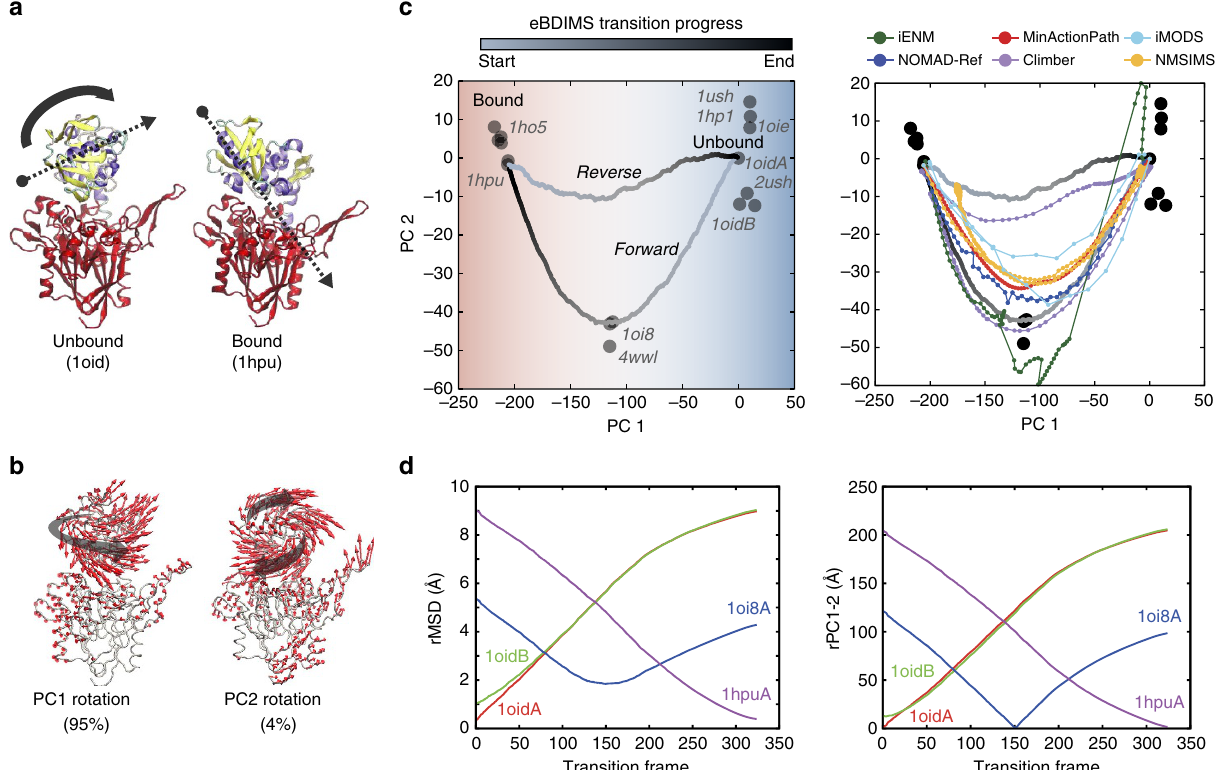
Figure 3 | Conformational transition of E. coli 5 0 -nucleotidase (5 0 NTase). ( a ) Crystallographic unbound (1oid) and nucleotide-bound (1hpu) states, showing one domain in red and the other coloured by secondary structure to visualize the ball-and-socket rotation (grey arrows). ( b ) Principal components of the X-ray ensemble (16 structures) decompose the complex rotation into a major and a minor rotation versus the reference 1oid. ( c ) Left: projections of the X-ray ensemble structures and the eBDIMS trajectories onto the PC1-2 subspace; PC1 alone separates the crystal structures into three clusters (same colour-coding as in Fig. 2). Right: comparison between the forward pathways computed by eBDIMS, iENM, NOMAD-Ref, MinActionPath and Climber. Reverse pathways generated by eBDIMS, iMODS, NMSIM and Climber also shown. ( d ) rMSD and PC1-2 distance between the forward trajectory and the sequence of crystallographic